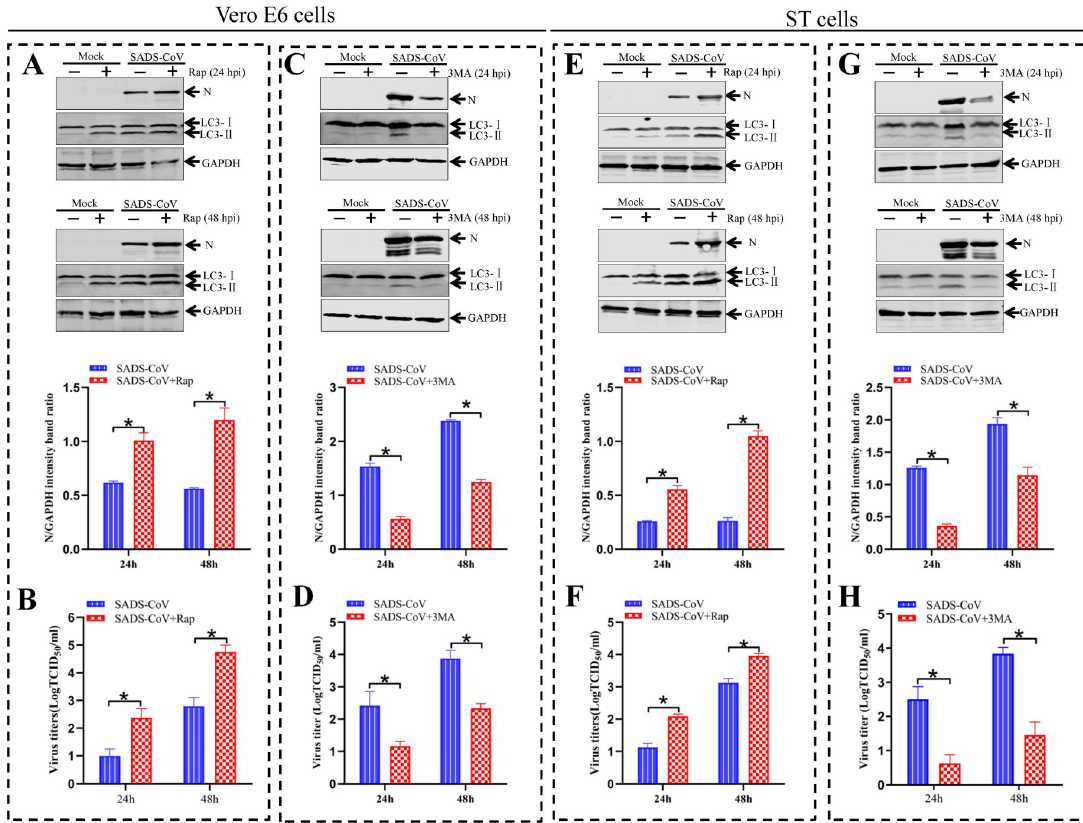
Fig 2. The effect of autophagy on SADS-CoV replication in cells treated with different pharmacological compounds. ( A and E ) Vero E6 and ST cells are mock-pretreated or pretreated with complete medium containing 500 nM rapamycin (Rap) for 2 h, and then subjected to SADS-CoV absorption for 1 h, and further cultured in fresh medium in the presence or absence of 500 nM Rap for 24 or 48 h. Cell lysates are analyzed by western blotting using anti-LC3 and -viral N antibodies. The presence of Rap is indicated with “+”. ( B and F ) Vero E6 and ST cells are pretreated and infected as described in A and C. Progeny virus yields are determined based on 50% tissue culture infective dose (TCID 50 ) per 1 mL in Vero E6 cells. ( C and G ) Vero E6 or ST cells are mock-pretreated or pretreated with complete medium containing 2 mM 3-methyladenine (3MA) for 2 h and then subjected to SADS-CoV absorption for 1 h and further cultured in fresh medium in the presence or absence of 2 mM 3MA for 24 or 48 h. Cell lysates are analyzed by western blotting. The presence of 3MA is indicated with “+”. ( D and H ) Vero E6 and ST cells are pretreated and infected as described in C and G. Progeny virus yields are determined based on TCID 50 per 1 mL in Vero E6 cells. Means and SD (error bars) of three independent experiments are indicated ( � P < 0.05).